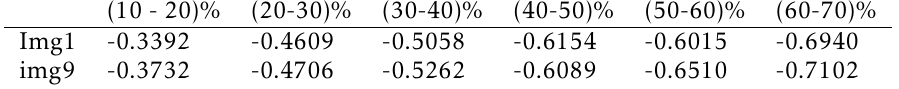
Table 3. First order deviation of entropy with respect to noise